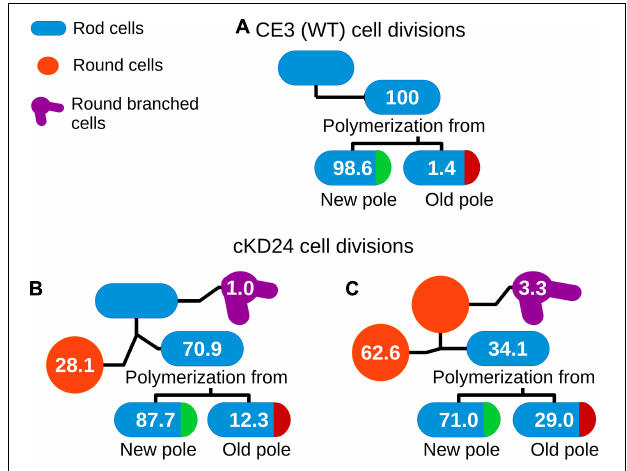
FIGURE 3 | Cell fate in R. etli CE3 (A) and cKD24 mutant (B,C) . Tracking of cell division events for 10 h of growth on agarose pads (1% in MMY medium) in absence of induction. Cells were imaged each 10 min using DIC microscopy. Numbers inside of each cartoon cell represents the percentage of successive division events for each cell shape. N was 217 for CE3 cells, 103 for cKD24 bacillary cells, and 91 for cKD24 round